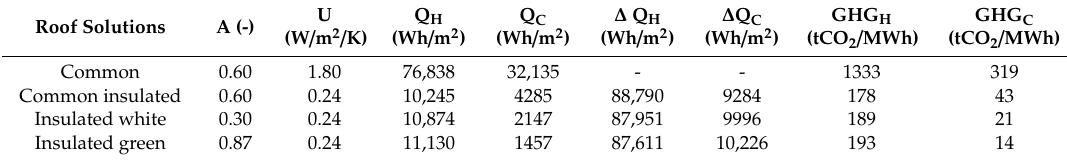
Table 7. Characteristics of roof solutions and energy e ffi ciency results.